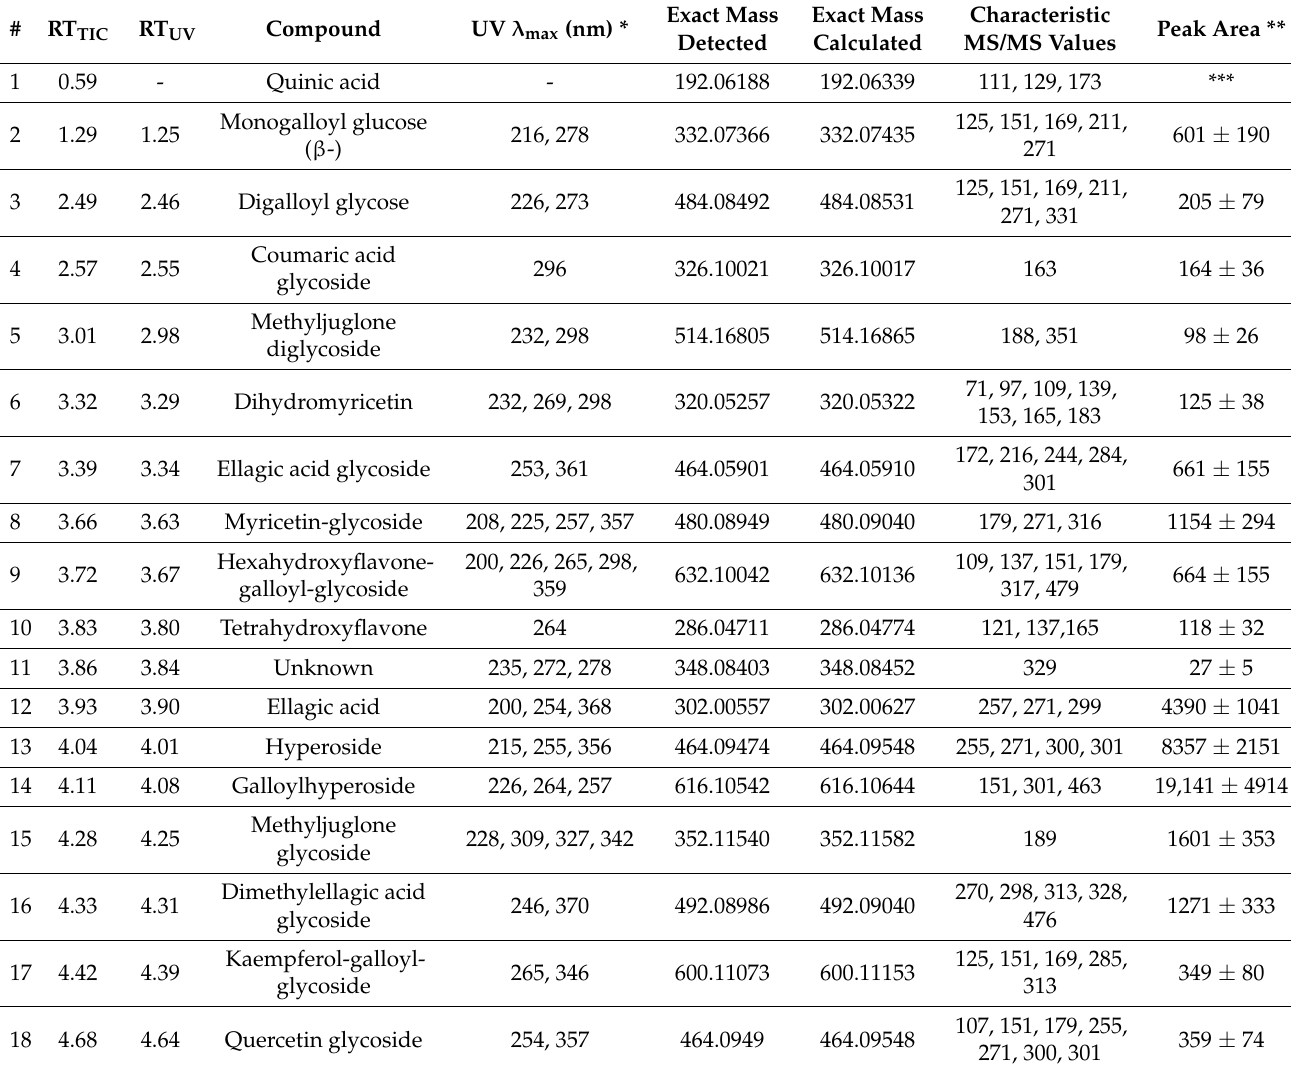
Table 1. Metabolic profile of the field-grown Drosera rotundifolia. Identified based on literature